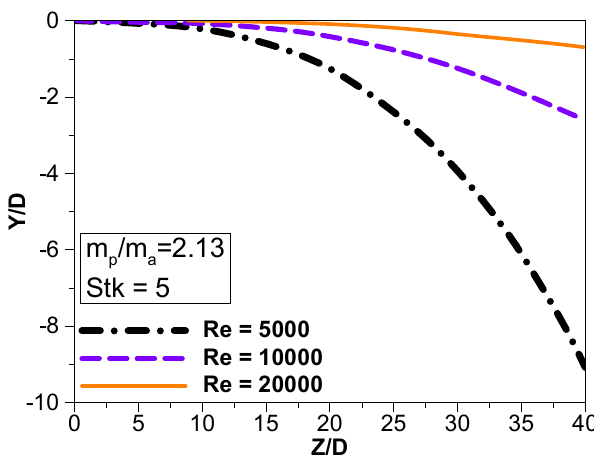
Figure 6. The effect of Reynolds number on the trajectory of the particle-laden jet.